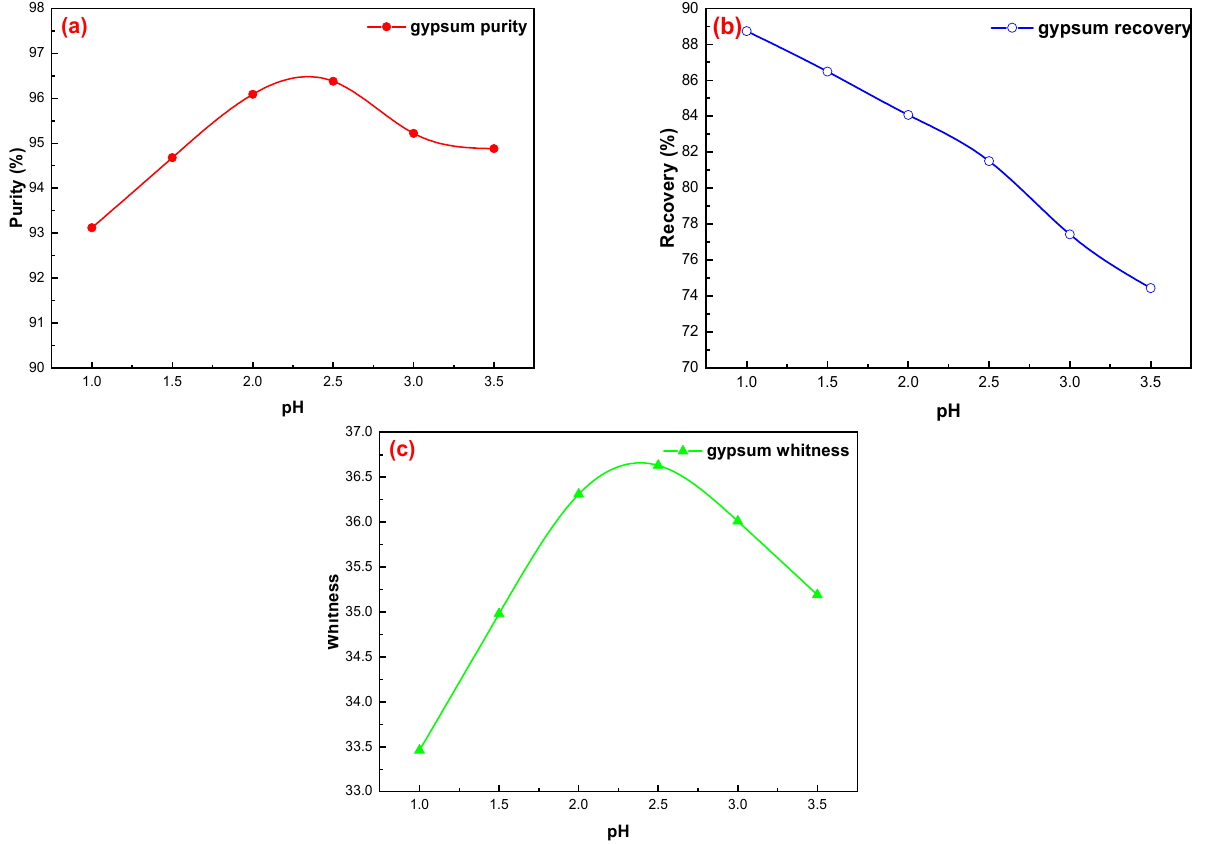
Figure 4. Effects of flotation pH value on gypsum purification: ( a ) gypsum purity, ( b ) gypsum recovery, and ( c ) gypsum whiteness.